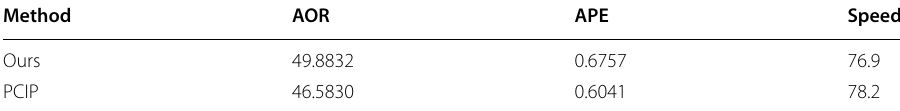
Table 4 Success and precision plots of different feature network slimming methods on OTB2013